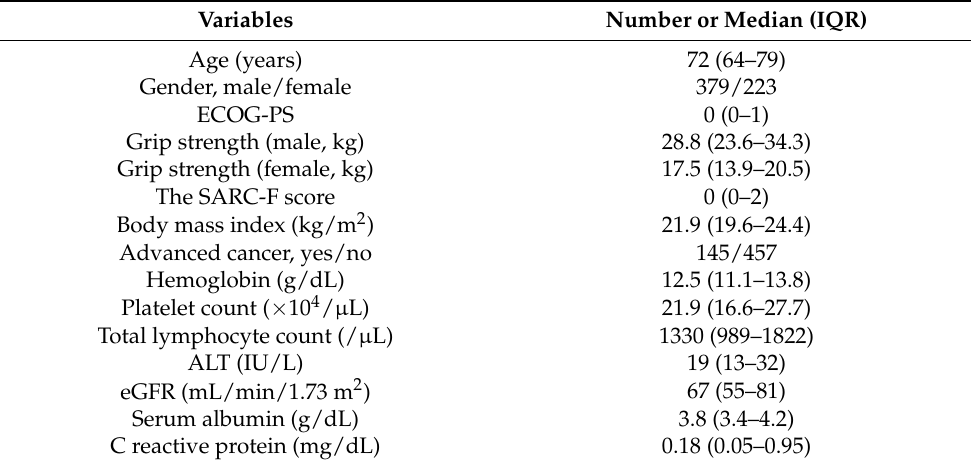
Table 1. Baseline characteristics ( n =